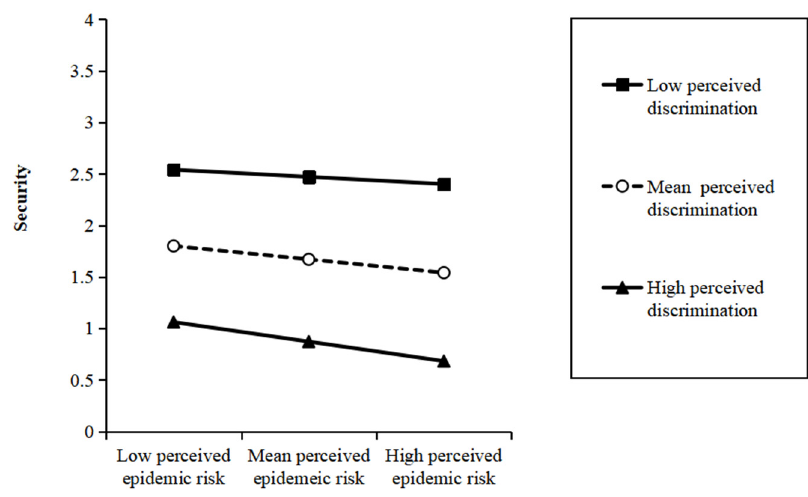
Figure 3. Interaction between perceived epidemic risk and perceived discrimination on security.